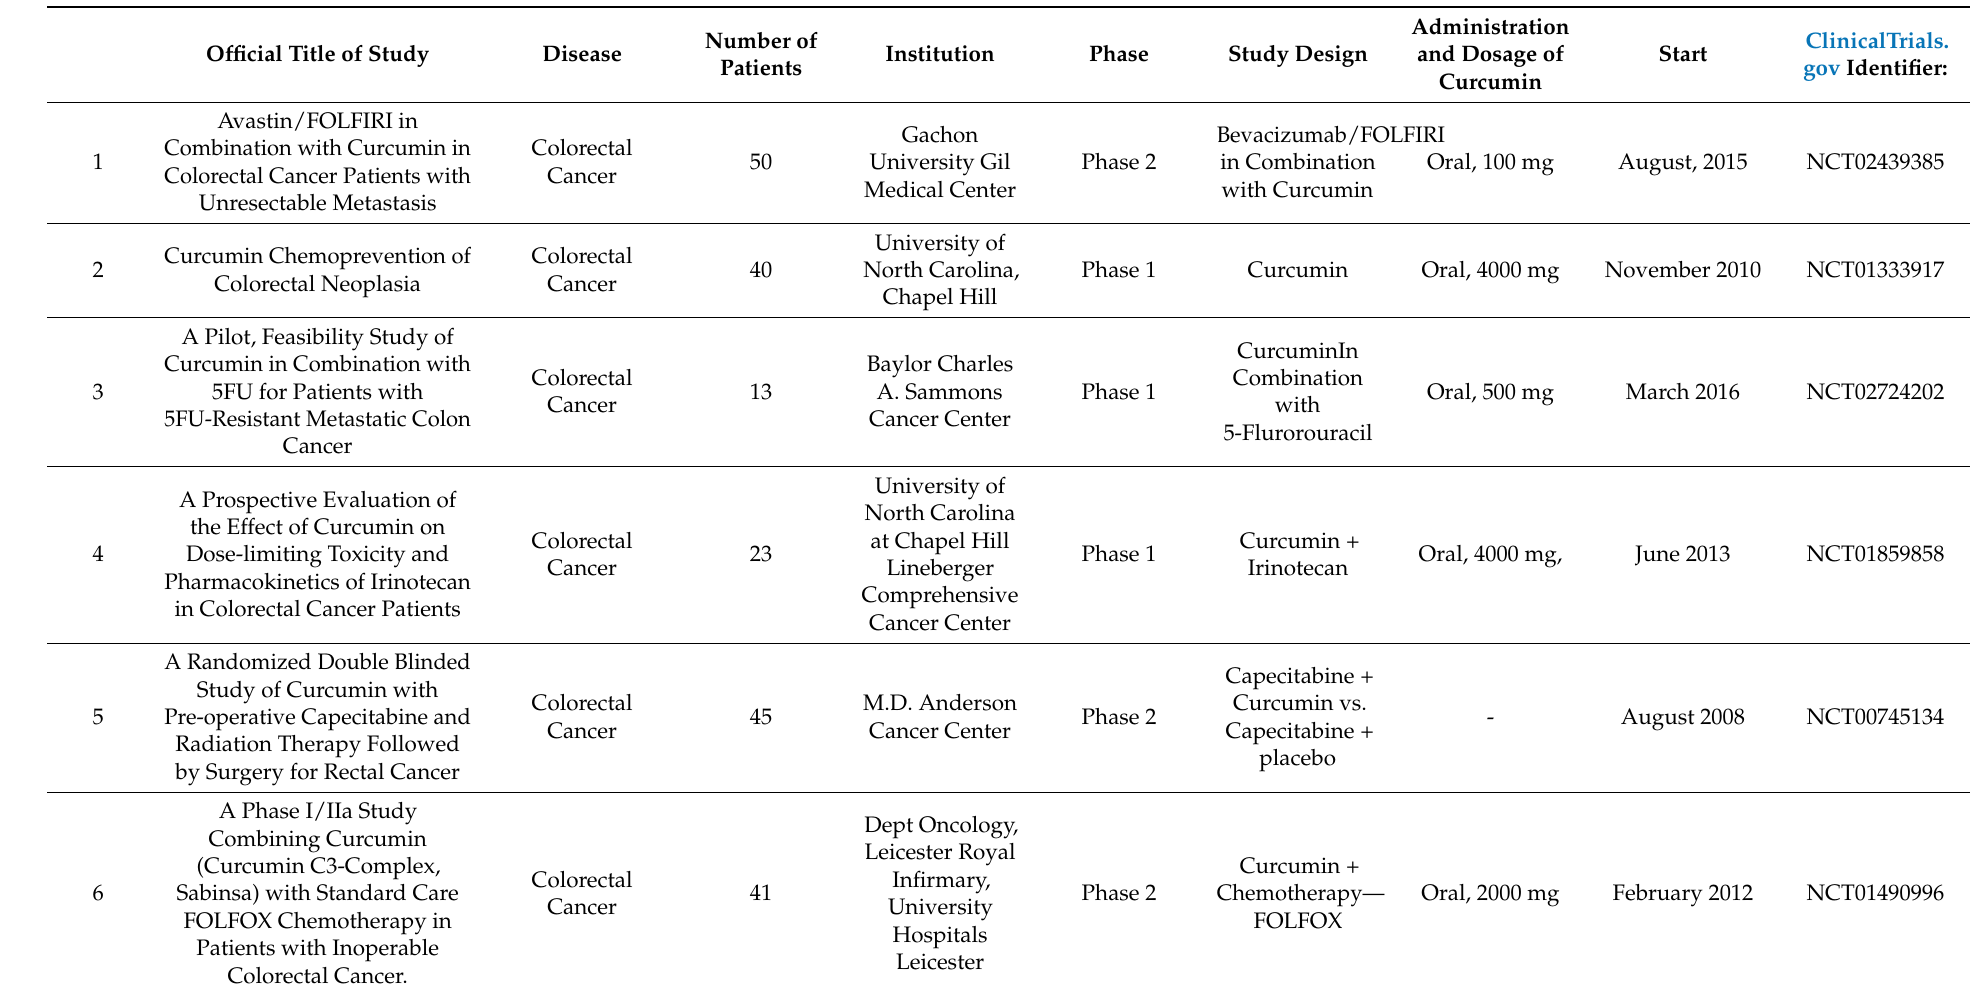
Table 1. A summary of active and completed clinical trials studying curcumin in cancer treatment and